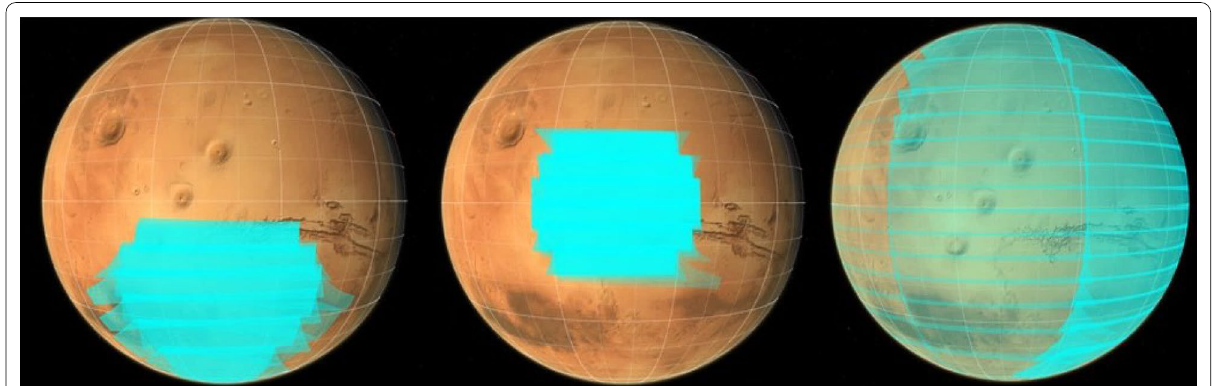
Fig. 21 Example of Mars observations on QSO‑M Dec 2027. Left: 3 observations of South hemisphere with 45 min time resolution: 1h30 time span. Center: 5 observations of a central zone with 30‑min time resolution: 2 h time span. Right: global coverage of lighted part of